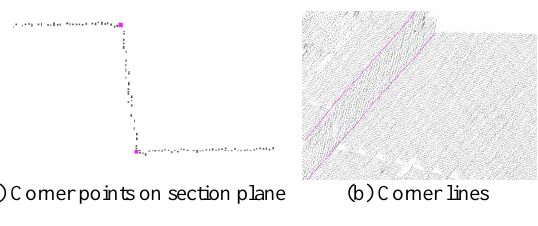
(a) Corner points on section plane (b) Corner lines Figure 6. Extracted road curb